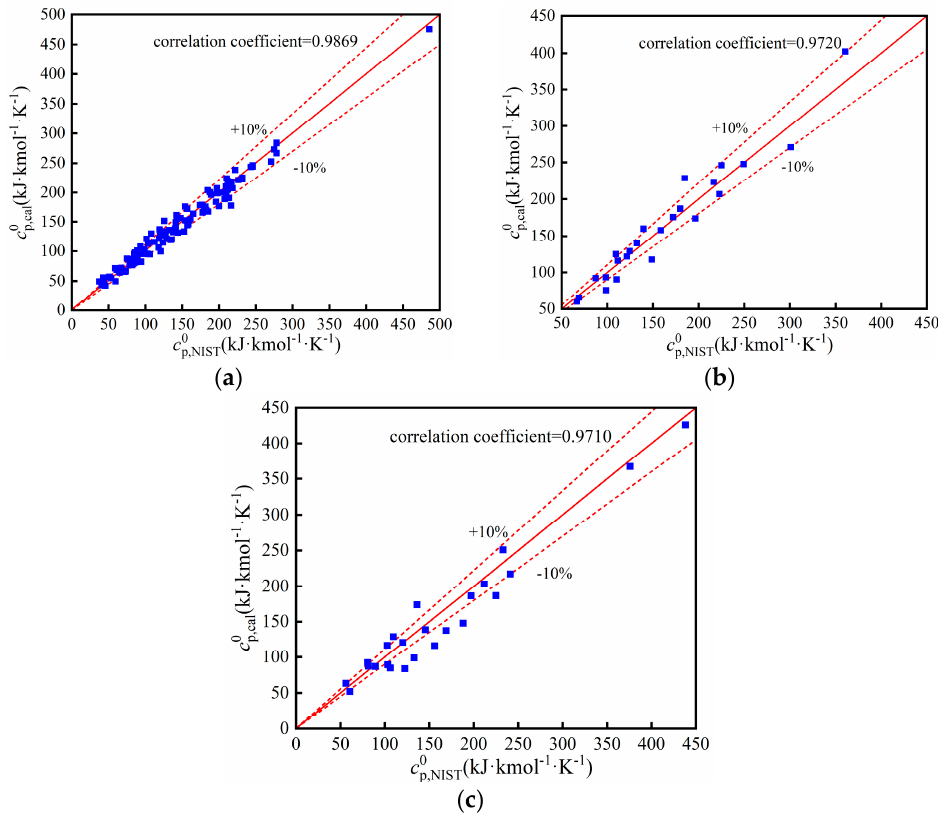
0 c : ( a ) Training set; ( b ) Validation set; ( c ) Test set. Figure A3. Comparison of c 0 p : ( a ) Training set; ( b ) Validation set; ( c ) Test p